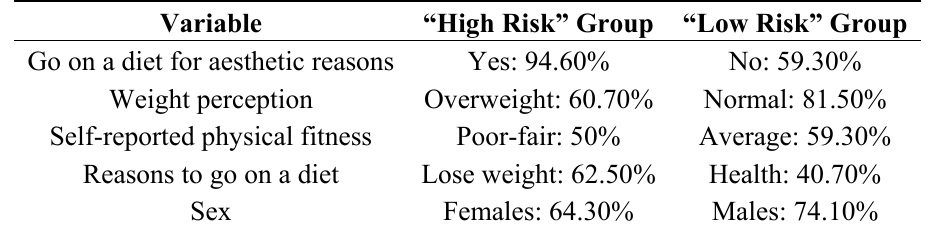
Table 6. Categorical variables in the high/low risk groups after cluster